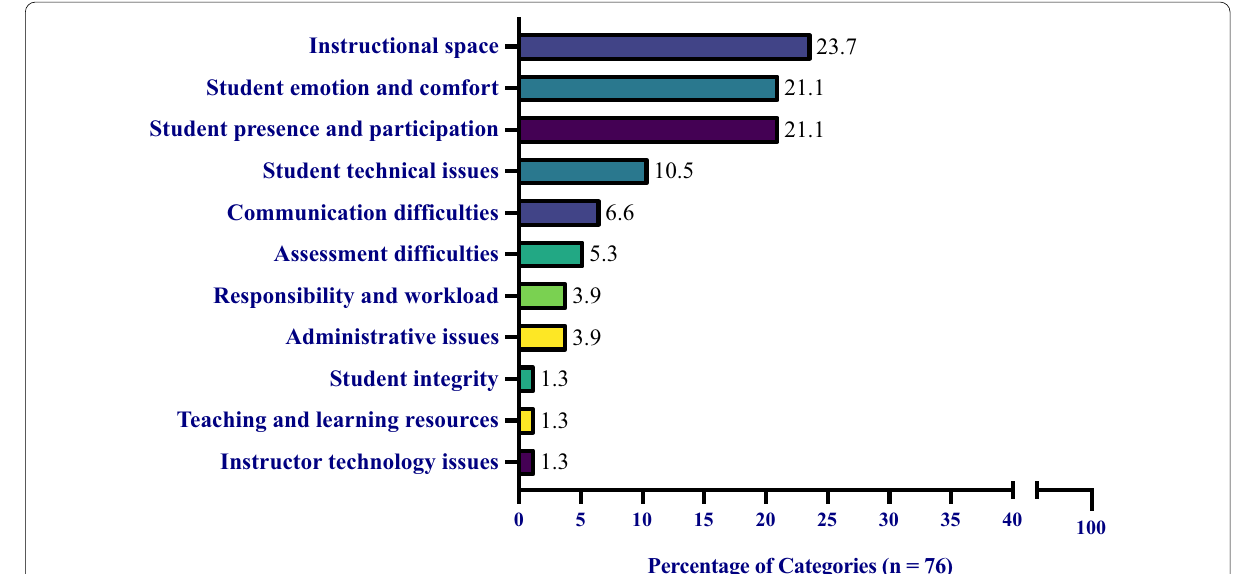
Fig. 5 Student perceived barriers during their transition to ERT. The percentage of barriers from students. Each value is the total number of each category divided by the total number of all categories, 76. For example, ‘instructional space’ was mentioned 18 times and 18/76 student used a single code more than